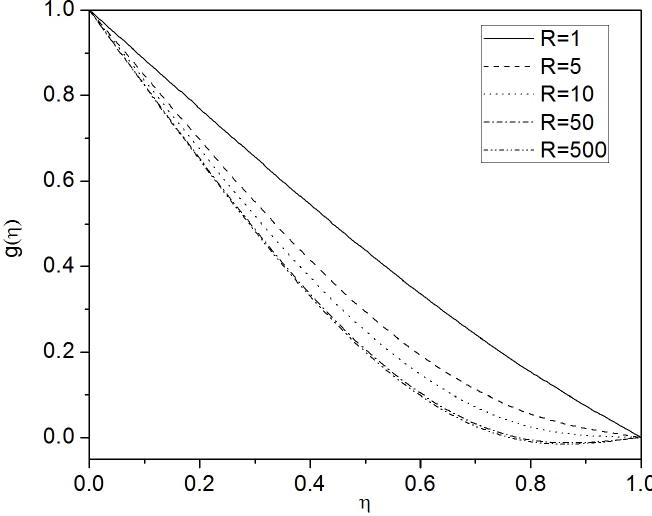
Fig. 5 Variations of g by increasing Reynolds number R